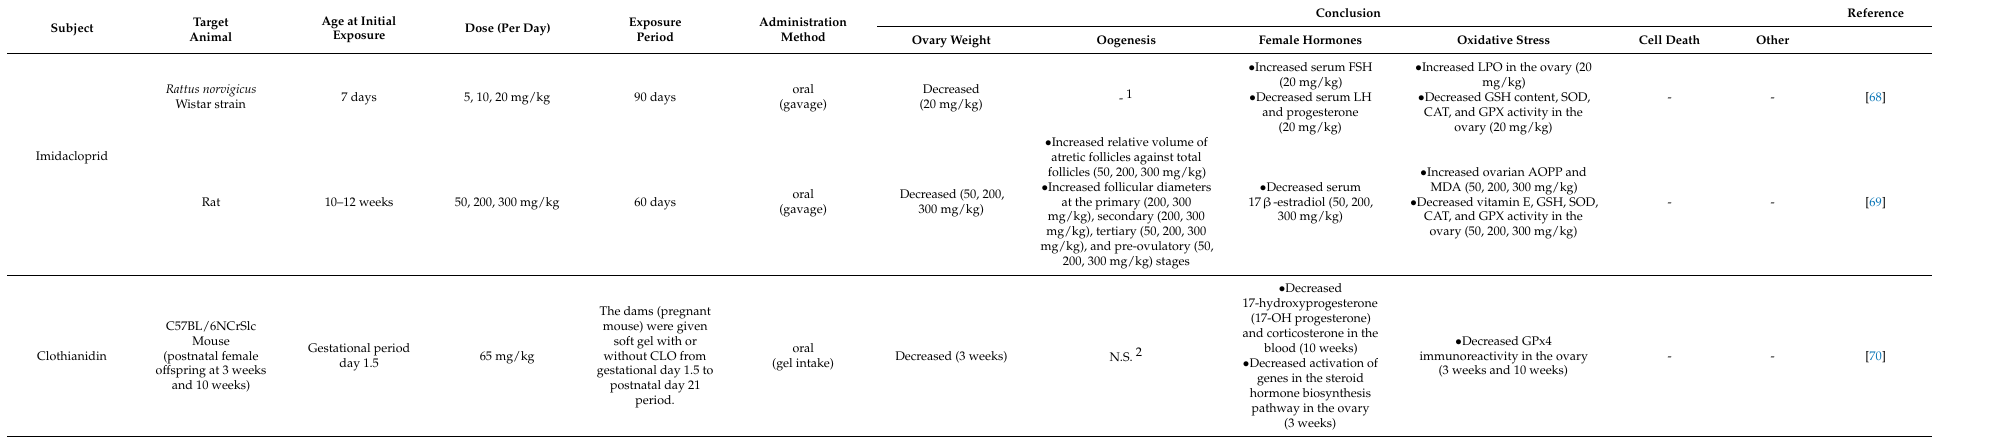
Table 4. Effects of neonicotinoid pesticides on the ovary reported in previous